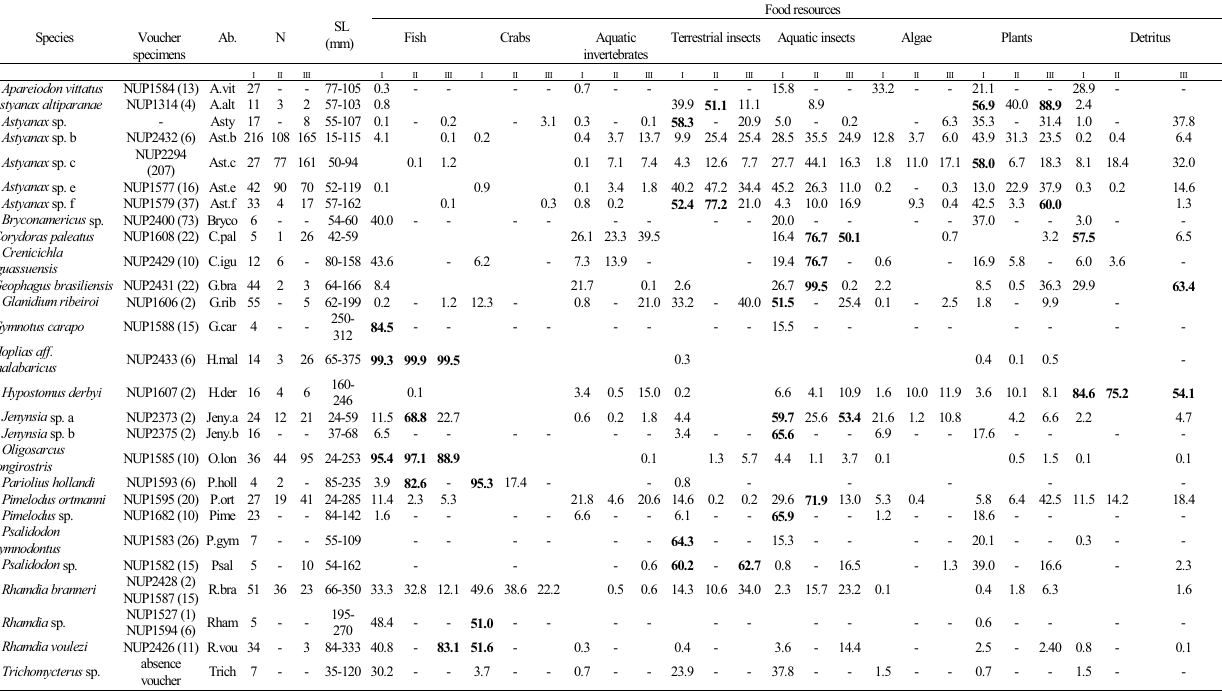
Table 1. Food resources used by the fish fauna of the Jordão River/Reservoir in phases I, II and III. The data represent the percentage in volume. Ab. = abbreviations, * = endemic species, - = absence of specimens. Numbers in boldface indicate values >